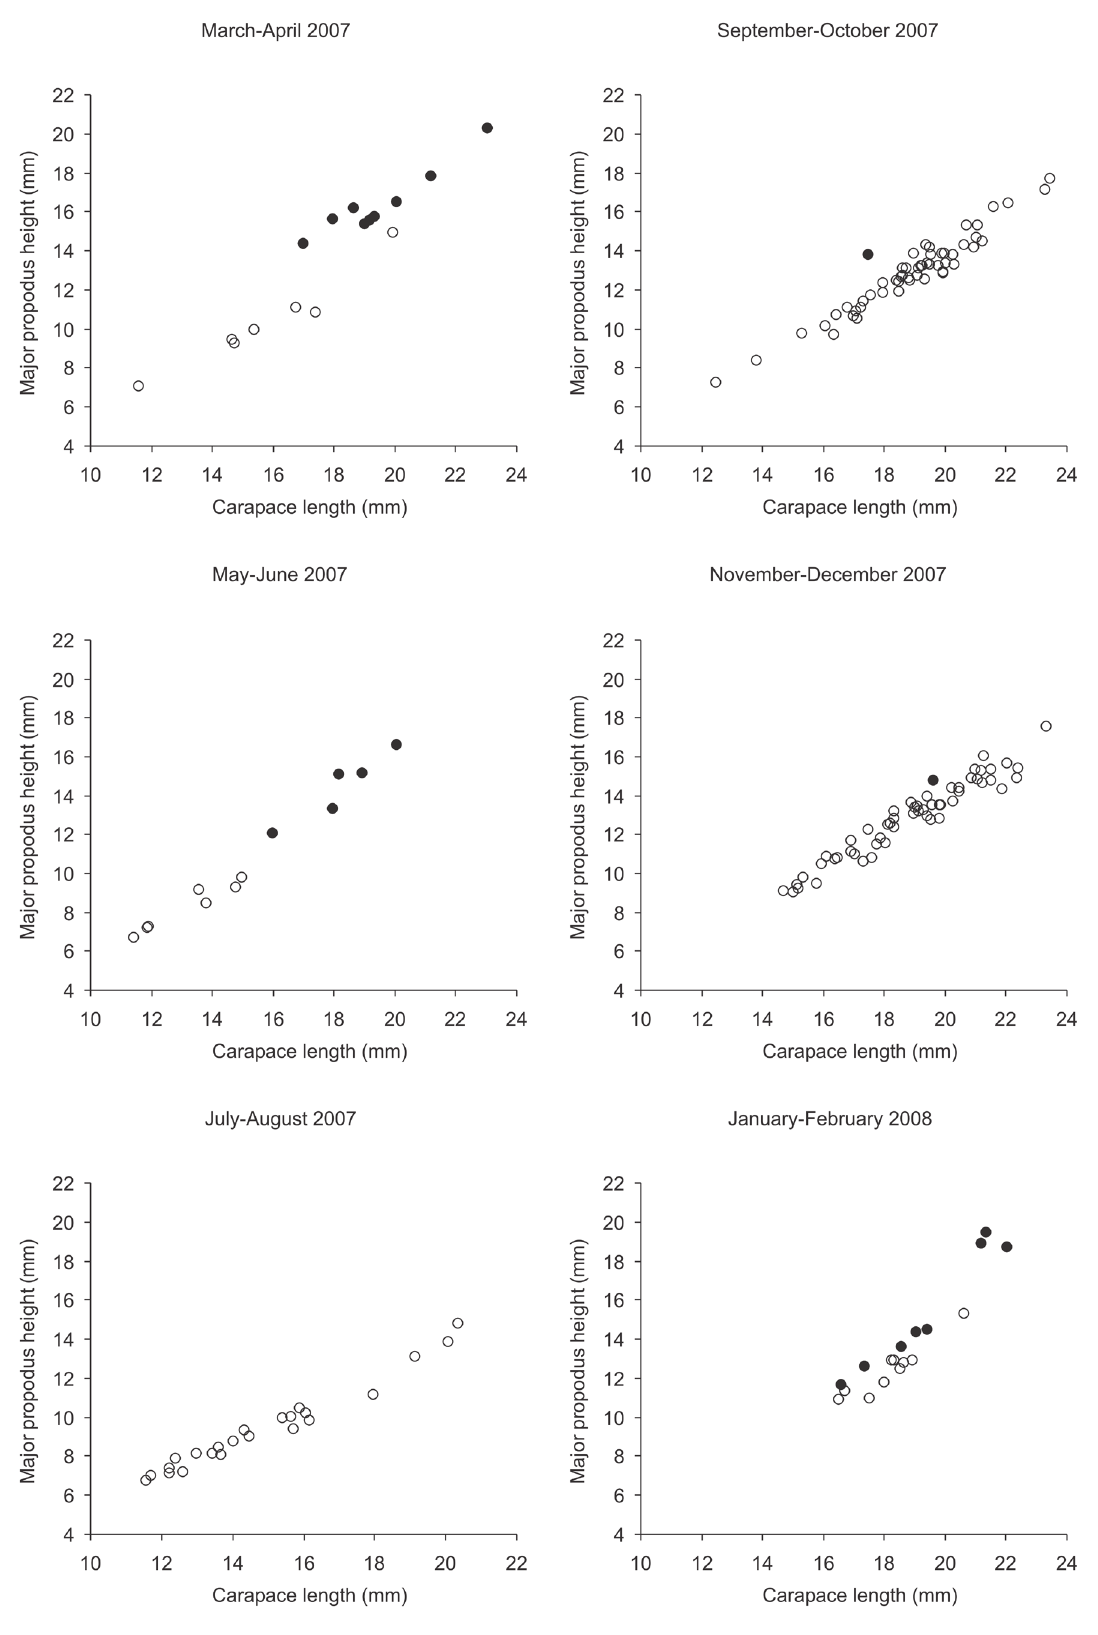
Figure 4. Aegla castro . Temporal sequence of major chelae propodus height vs . carapace length scatterplots of adult males. Empty circles = morphotype I; full circles = morphotype II. Other chelae dimensions exhibited very similar